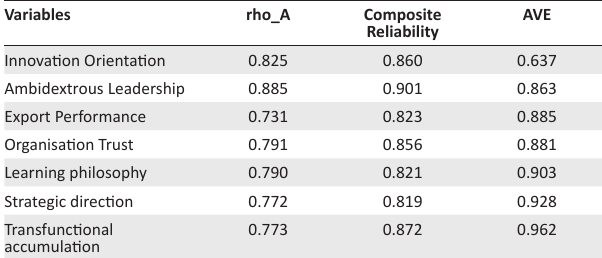
TABLE 3: Reliability Result.